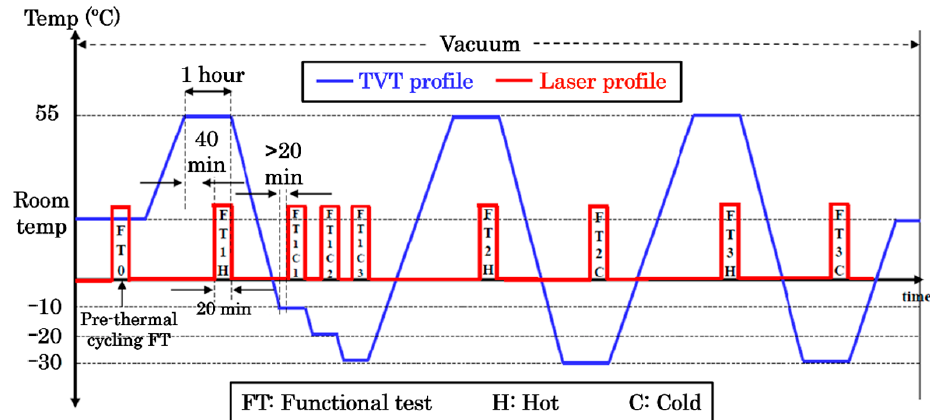
Figure 10. Functional tests under thermal vacuum environment.